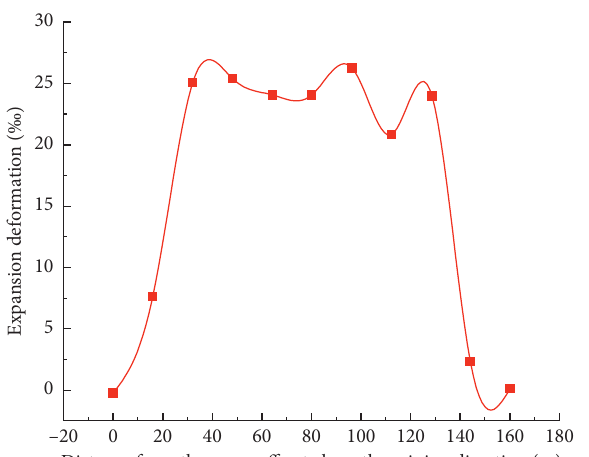
Figure 13: The expansion deformation changes in the protected layer with the advancing of the rock-coal composite protective layer.